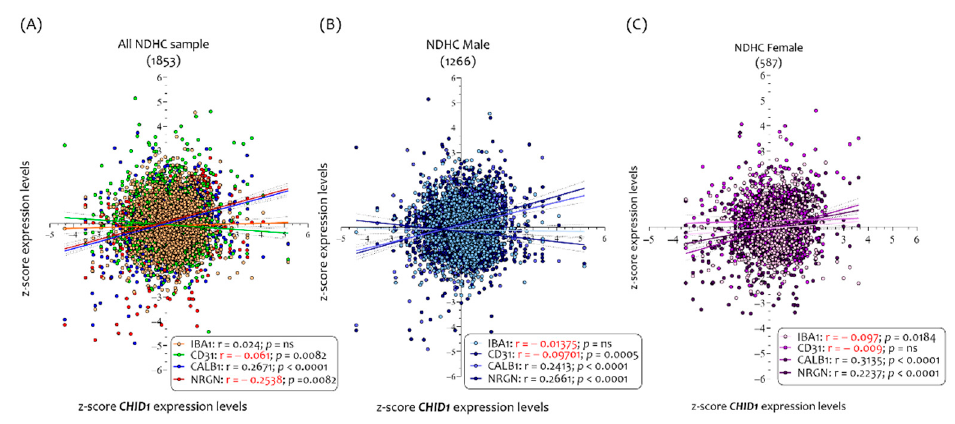
Figure 4. Correlation analysis between brain CHID1 expression levels and neurological markers in NDHC subjects. Analysis of the correlation between the CHID1 , IBA1 , CD31, CALB1 , and NRGN expression levels in all brains (1853) ( A ), and in brains sorted according to 1266 males ( B ) and 587 females ( C ) belonging to NDHC subjects. Data in the figure are indicated as z-score intensity expression levels and presented graphically as dot plots. p values < 0.05 were considered to be statistically significant.